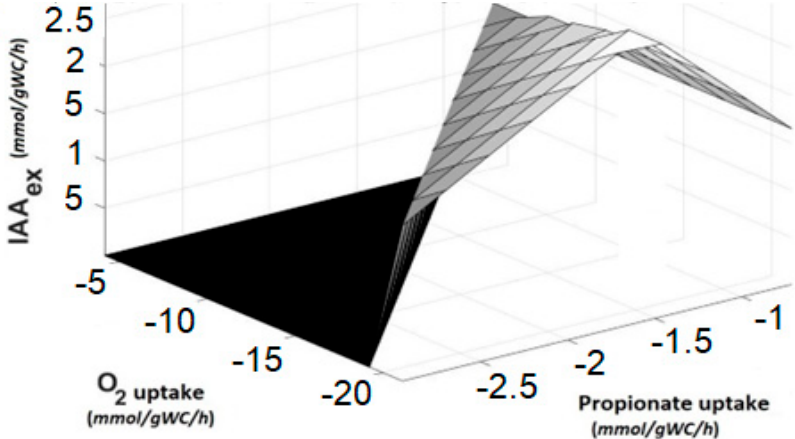
Figure 7. Double robustness analysis of IAA production rate as a function of propionate uptake and O 2 consumption. Negative values of the propionate and oxygen uptake are indicating that these substrates are consumed.